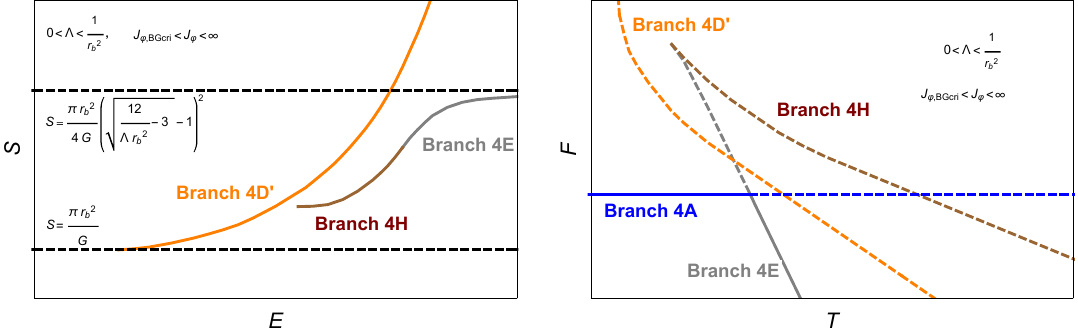
and J ( r Λ , M ) < J . The ϕ,BGcri b , ϕ < ∞ r 2 b